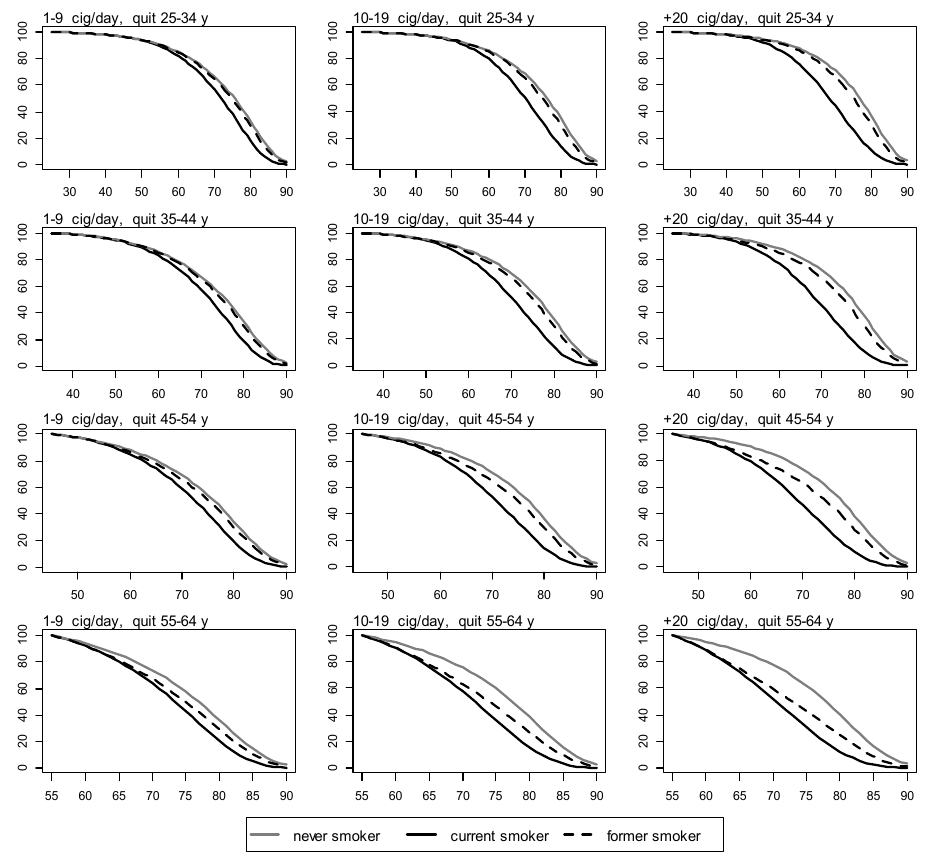
Figure 4. Survival for never, current, and former women smokers by number of cigarettes smoked per day and age of quitting. y axis: proportion of survival. x axis: age in